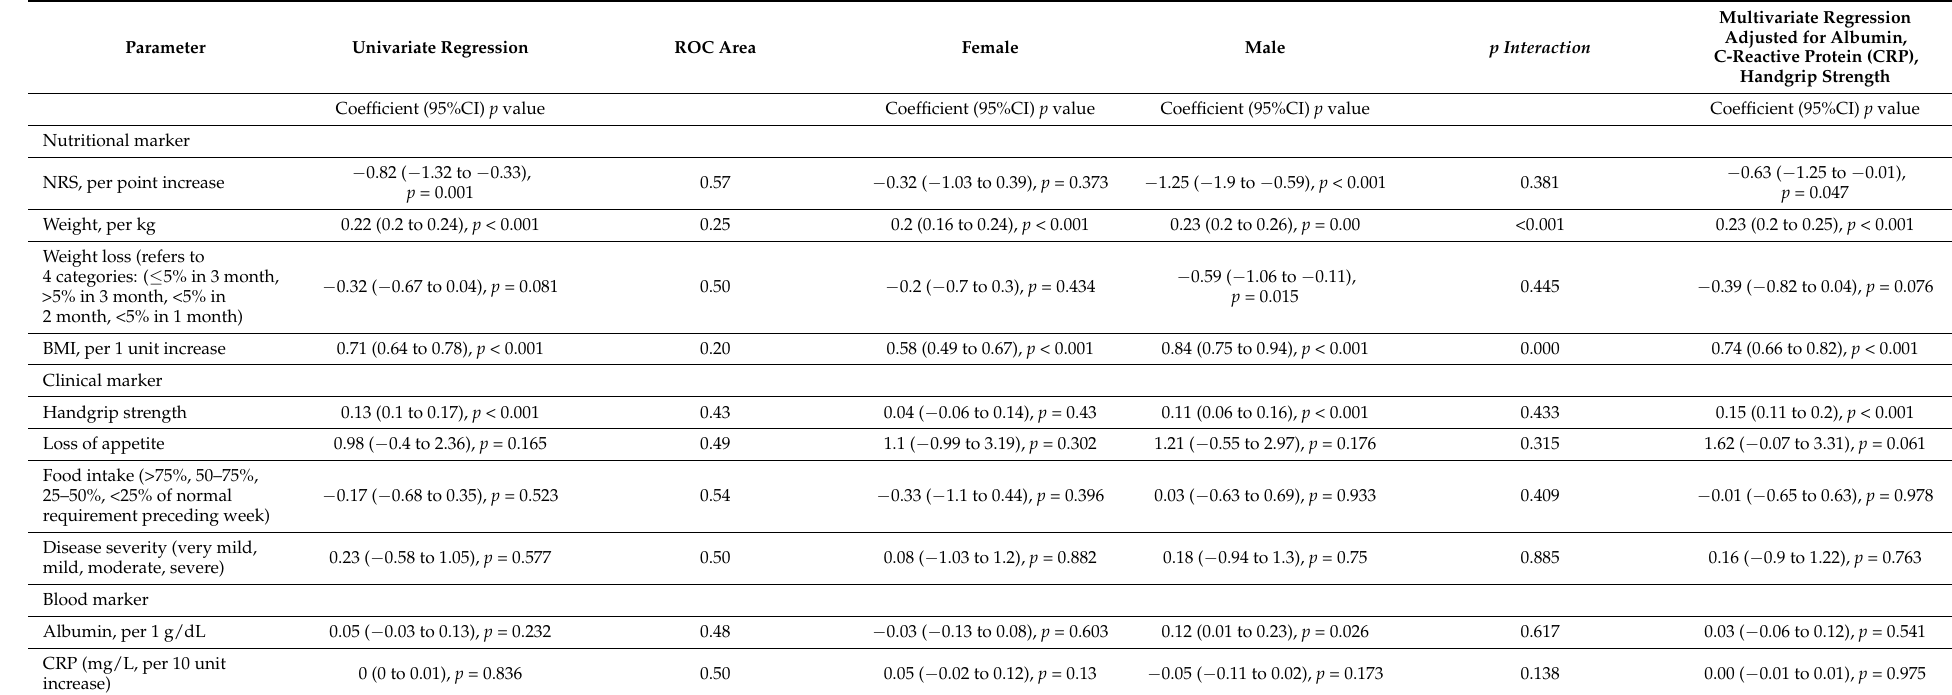
Table 2. Association of SMI with clinical